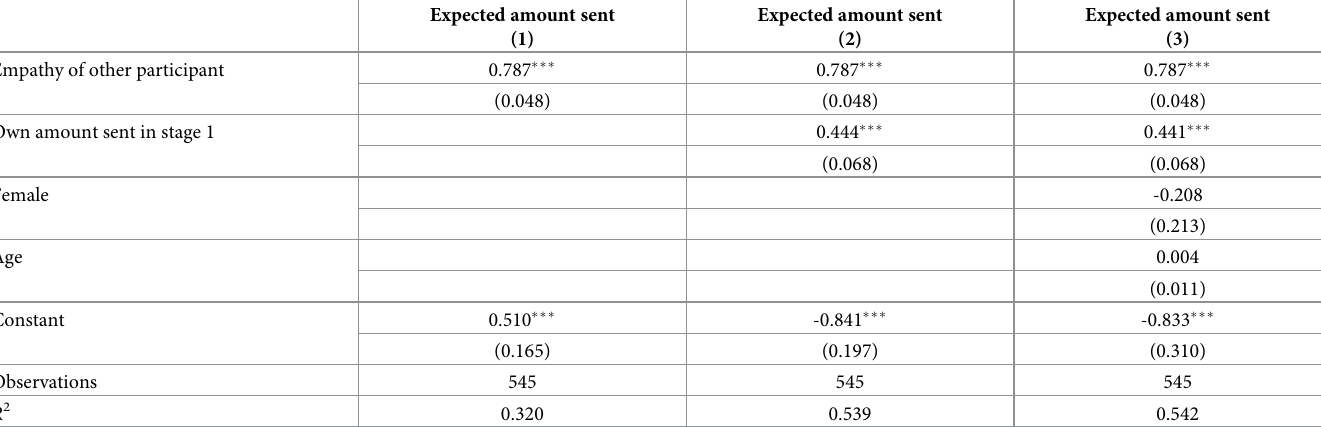
Table 2. Effect of another participant’s empathy on expected prosocial behavior—Pooled OLS regression.